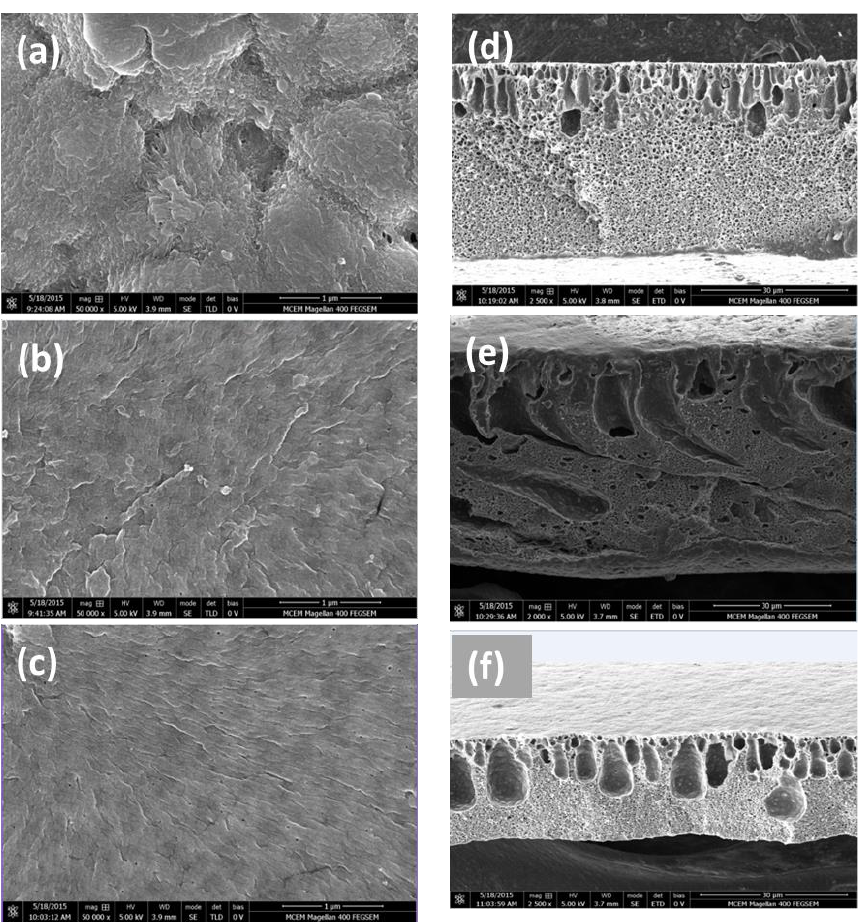
Figure 3. SEM images of top surface for ( a ) pure PVDF, ( b ) PVDF/GO-s, and ( c ) PVDF/GO-h membranes and images ( d – f ) are SEM cross sections for the same membranes, respectively.